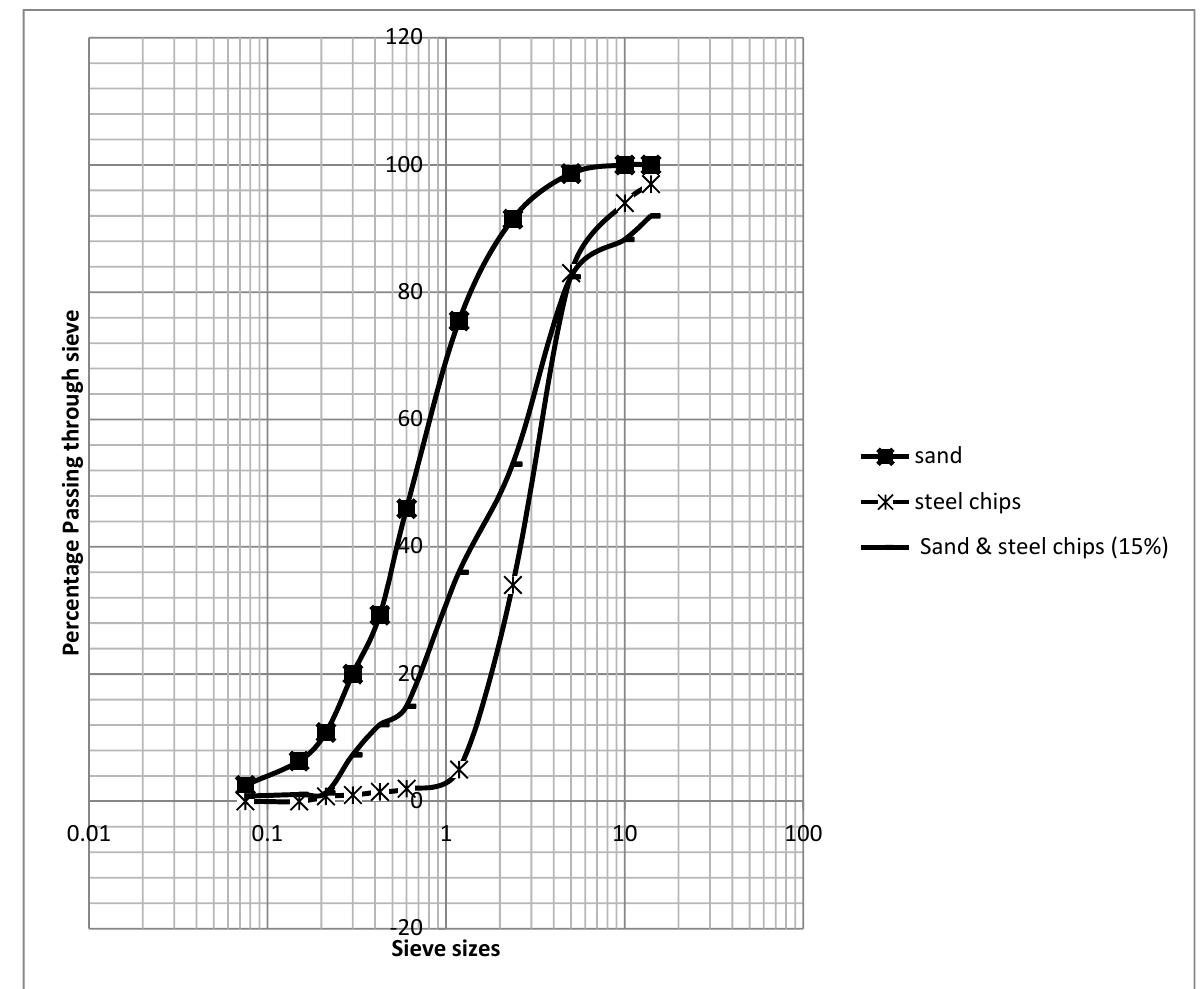
Figure 5. Grading curves for sand and steel chips (15%)